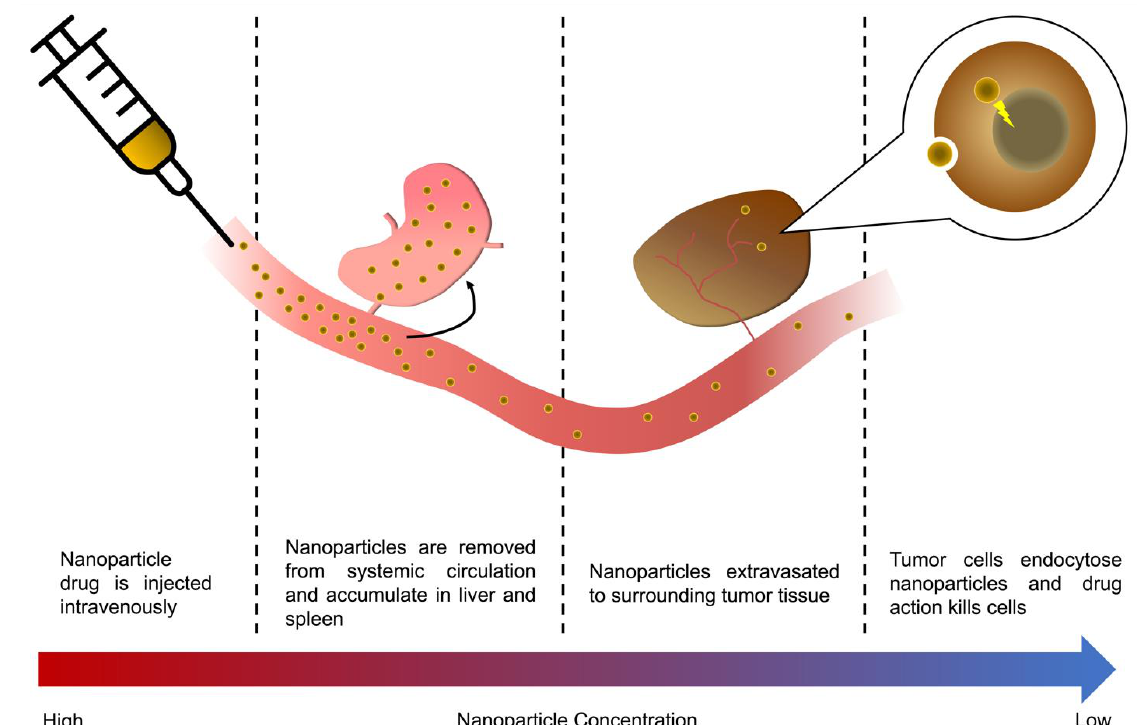
Figure 1. A nanoparticle’s journey to the tumor, from injection to mode of action. The majority of an i.v. injected nanoparticle drug will, in a matter of hours, be metabolized by the RES organs, accumulating in the liver and spleen, or be cleared through renal clearance depending on particle size. Those particles that are not cleared through RES uptake or renal clearance will eventually accumulate in the tumor vasculature are extravasated to surrounding tissue, either via leaky vessels in the tumor or active transcytosis across the vascular wall. Eventually, a small fraction of the original dose is endocytosed into tumor cells, killing them.